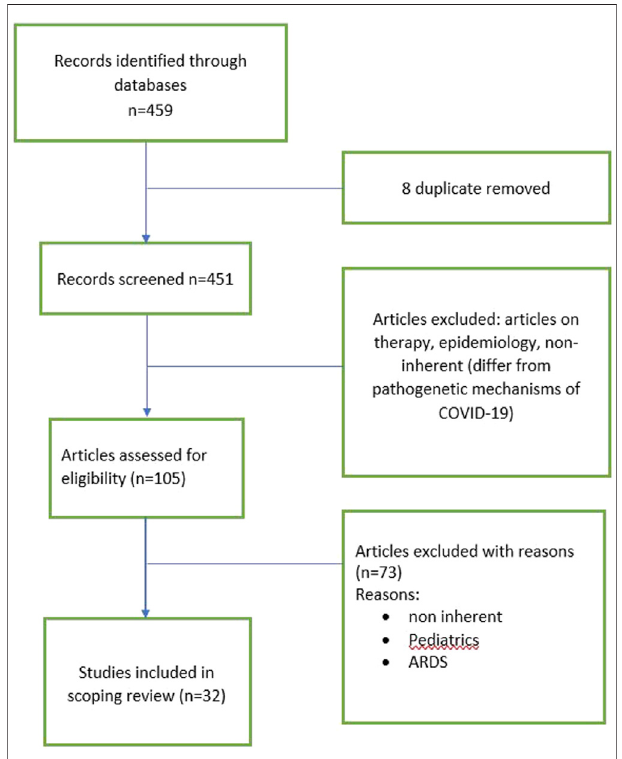
FIGURE 1 | Flowchart of selected manuscript.